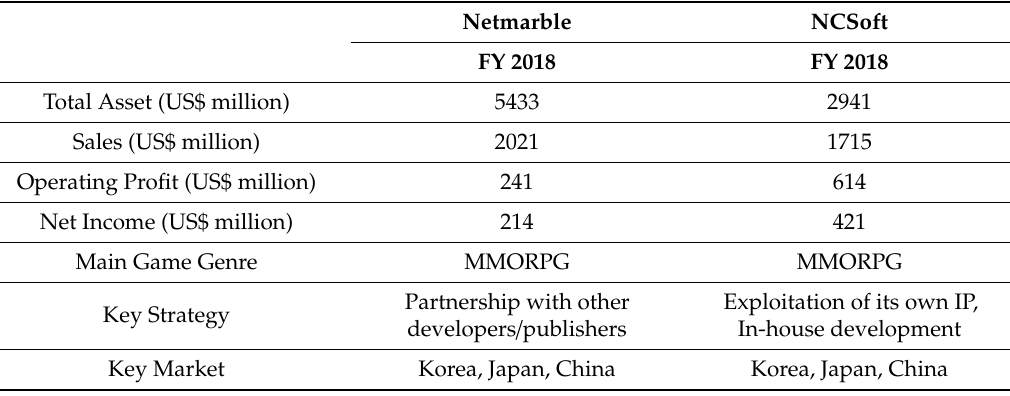
Table creation and analysis conducted by the authors, Sources: [18,19].